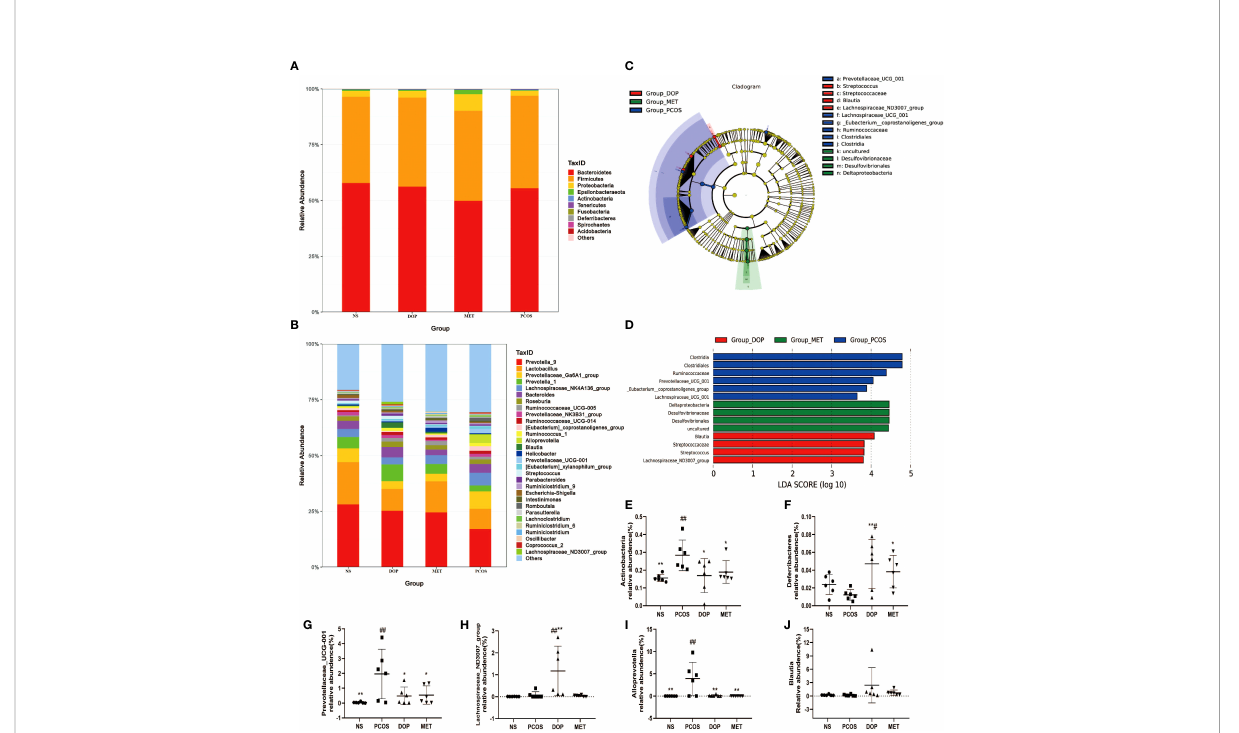
FIGURE 7 Effect of DOP treatment on gut microbial composition, n = 6. (A) Microbial distribution at the phylum level. (B) Microbial distribution of the top 30-genus level. (C) Cladograms representing the linear discriminant analysis effect size (LEfSe) results. (D) Linear discriminant analysis (LDA) results between different experimental groups. LDA scores above 3.00 and p < 0.05 are shown. (E-J) Relative abundance of Actinobacteria , Deferribacteres , Prevotellaceae_UCG_001 , Lachospiraceae_ND3007_group , Alloprevotella , and Blautia between all groups. Note: compared with the PCOS group: * p < 0.05, ** p < 0.01; compared with the NS group: # p < 0.05, ## p < 0.01.